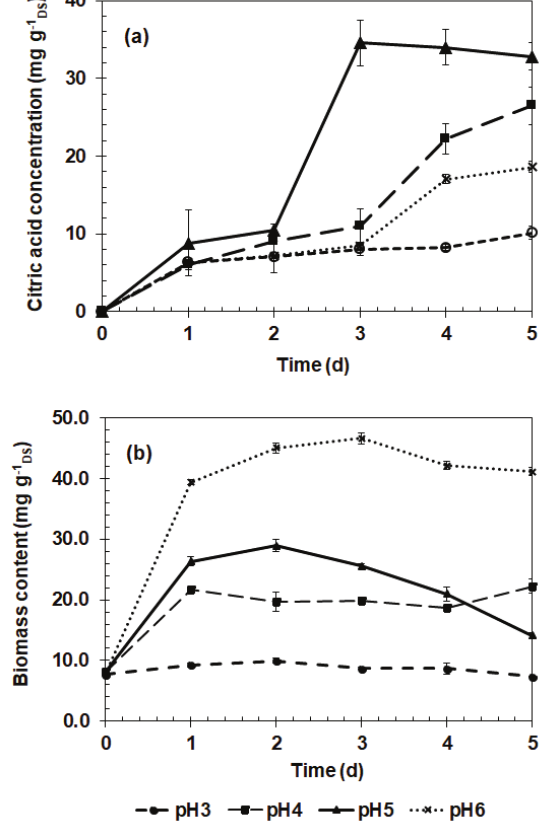
Fig. 3 – Citric acid production from the SSF at different initial banana peel pH (a) Citric acid concentration (b) Biomass